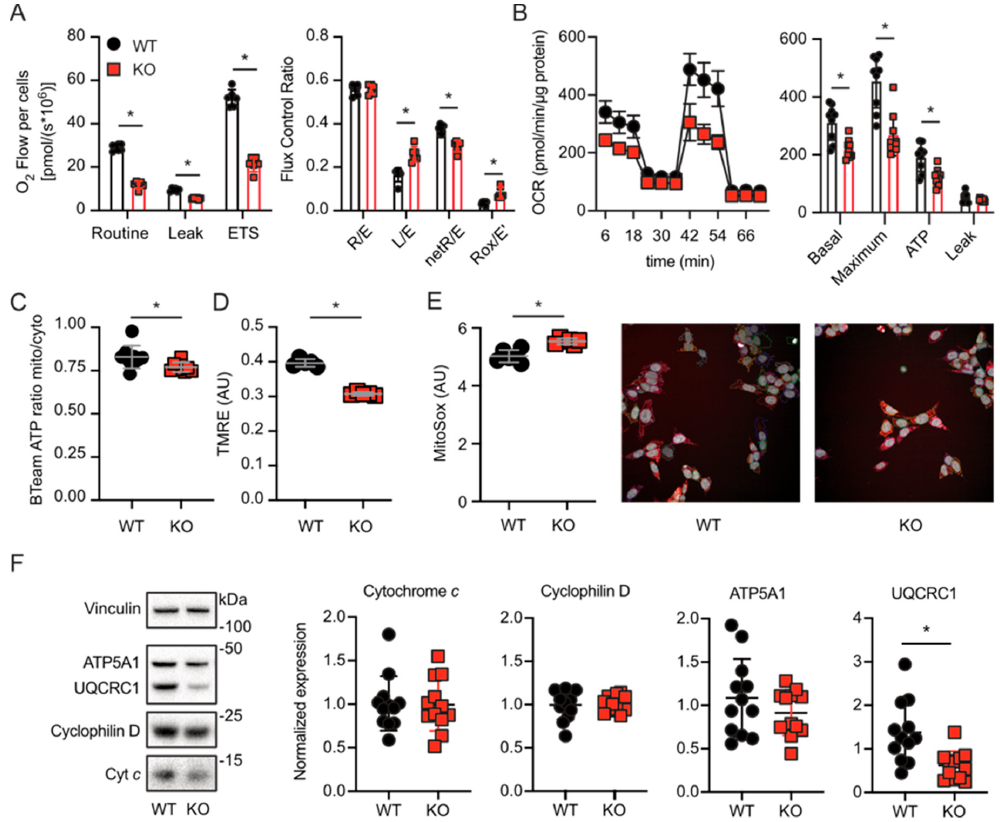
Figure 3. Lack of TMBIM5 reduces mitochondrial potential, thereby resulting in defective bioenergetics and increased superoxide production. ( A ) Oxygen consumption measured using high-resolution respirometry with an Oroboros O2k device. Routine reflects steady-state respiration in intact, healthy cells. Leak respiration is defined as oxygen consumption after the addition of oligomycin to block complex V. Maximal electron transfer system capacity (ETS) is induced by titration of the uncoupler FCCP. All graphs show the mean ± SEM values of n = 3 di ff erent experiments. The graph on the left was analyzed using Welch’s t -test, the graph on the right was analyzed using two-way ANOVA and Tukey’s multiple comparison test. Graphs show the mean ± SD of n = 3 di ff erent experiments. * p < 0.05. ( B ) Oxygen consumption rate (OCR) was alternatively measured using a Seahorse Xf analyzer, which confirmed the results obtained with the Oroboros O2k. OCR was measured under basal conditions followed by the sequential addition of oligomycin (at 18 min), FCCP (at 36 min), and rotenone / antimycin A combination (at 54 min). Graphs show the mean ± SD of n = 3 di ff erent experiments (each performed in triplicate). * p < 0.05 ( C ) Cytosolic and mitochondrial ATP levels were quantified using the bioluminescence energy transfer (BRET)-based ATP biosensor BTeam, and the mitochondrial / cytosolic ATP ratio calculated revealed a reduced ATP production in TMBIM5-KO cells. * p < 0.05 analyzed with unpaired t -test. ( D ) Staining with TMRE shows that TMBIM5-KO cells have a significantly lower mitochondrial potential. * p < 0.0001. Analyzed with Welch’s t test. ( E ) Mitochondrial superoxide production was measured via staining with MitoSOX, revealing increased basal levels in TMBIM5-KO cells. * p < 0.01 analyzed with Mann–Whitney test. ( F ) WT and TMBIM5-KO (KO) cells were immunoblotted for mitochondrial proteins. Vinculin served as loading control; size is indicated. Quantification of expression levels of cytochrome c , cyclophilin D, and subunits of the electron transfer system (ETS) complex III (UQCRC1) and V (ATP5A1) abundance relative to vinculin revealed reduced expression levels of complex III in TMBIM5-KO cells. Each data point represents one immunoblot. Mean ± SD is indicated, * p < 0.01, analyzed with Welch’s t -test. In line with these mitochondria being compromised, we corroborated that TBMIM5-KO cells ( i ) produced less mitochondrial ATP as quantitated by the ratiometric reporters BTeam targeted